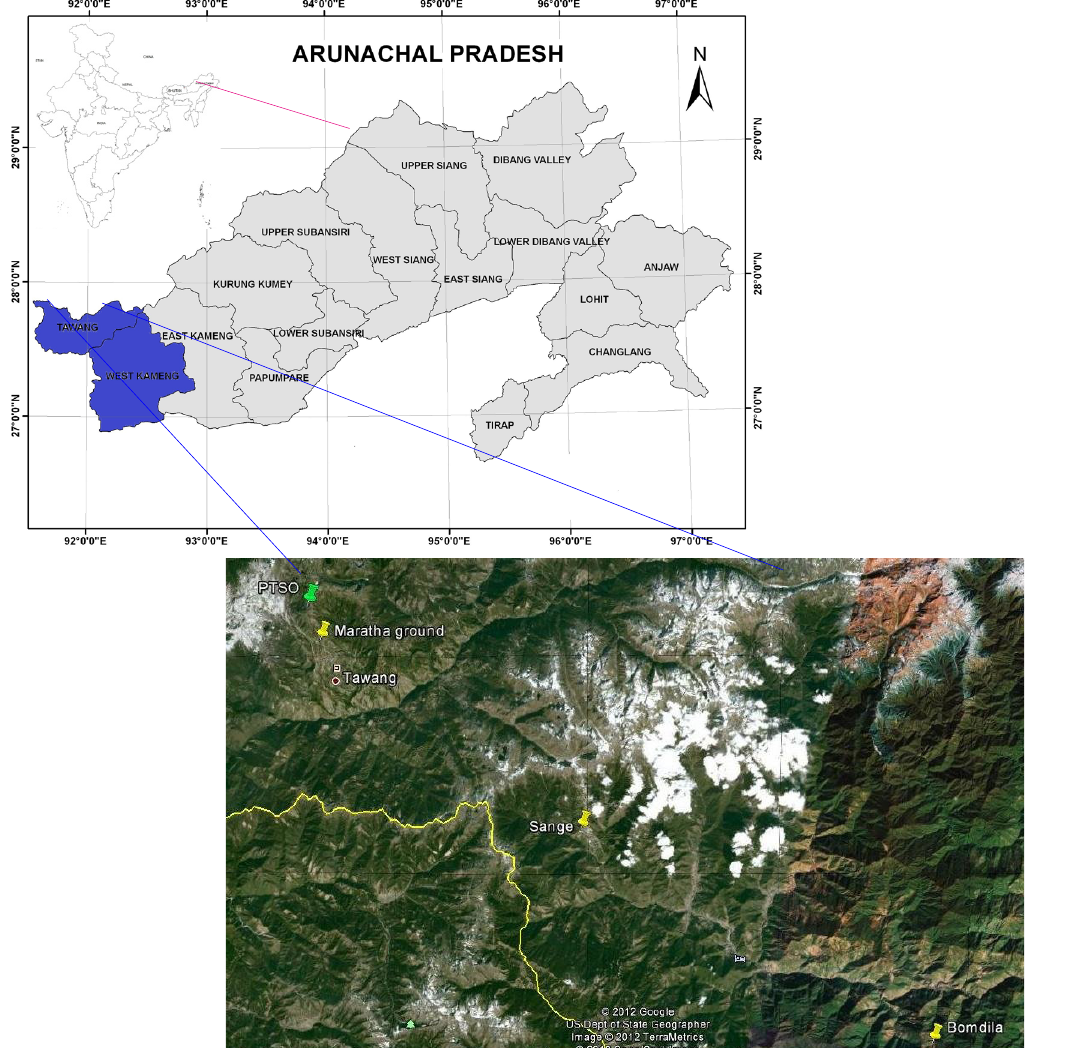
sites.Figure 1. Location of the study sites in West Kameng and Tawang districts of Arunachal